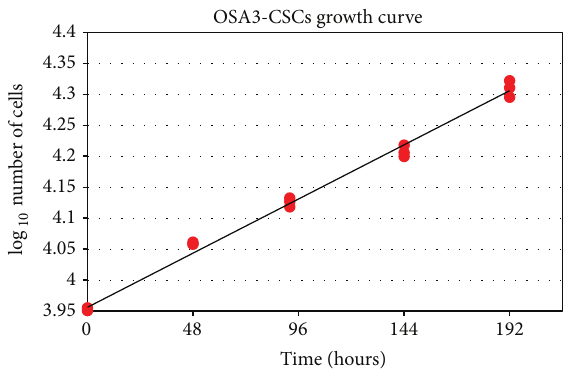
Figure 10: Growth curve. Graphical representation in linear regres- sion of the kinetics of growth for OSA3-CSCs line cultured in GM ( 𝑦 = 0.0018𝑥 + 3.956 ; 𝑅 2 = 0.99 ). Experiment is carried out in